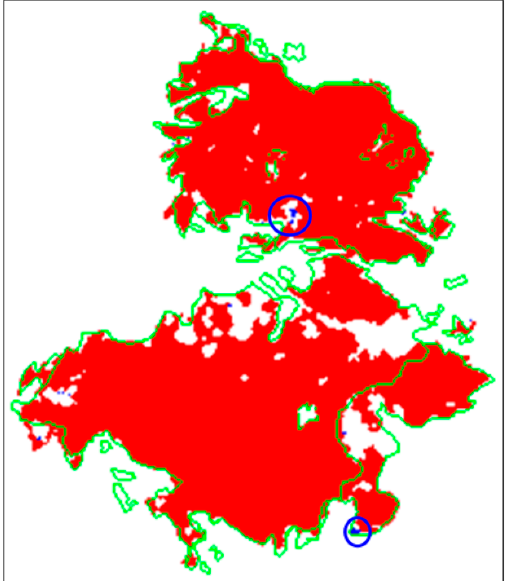
Figure 13. AUTOBAM-derived BA map for the Tuscany case study, where the pixels included in the BA because of the application of the fuzzy logic-based approach are colored in blue; some of them are also highlighted by the blue circles. Green lines represent the perimeter of the CEMS-derived burned